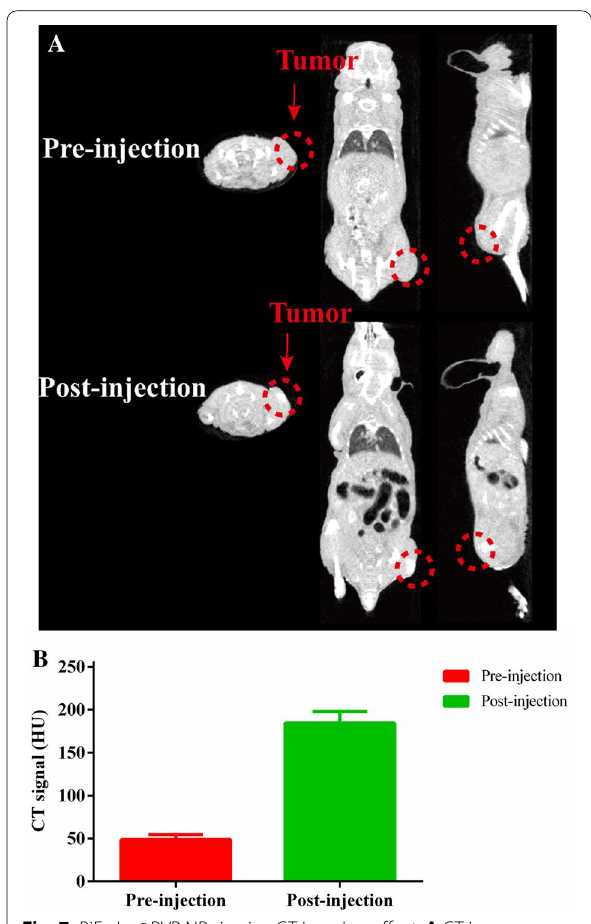
Fig. 7 BiF 3: Ln@PVP NPs in vivo CT imaging effect. A CT images before and after BiF 3: Ln@PVP NPs injection and B the corresponding CT value. The red circle indicates tumor